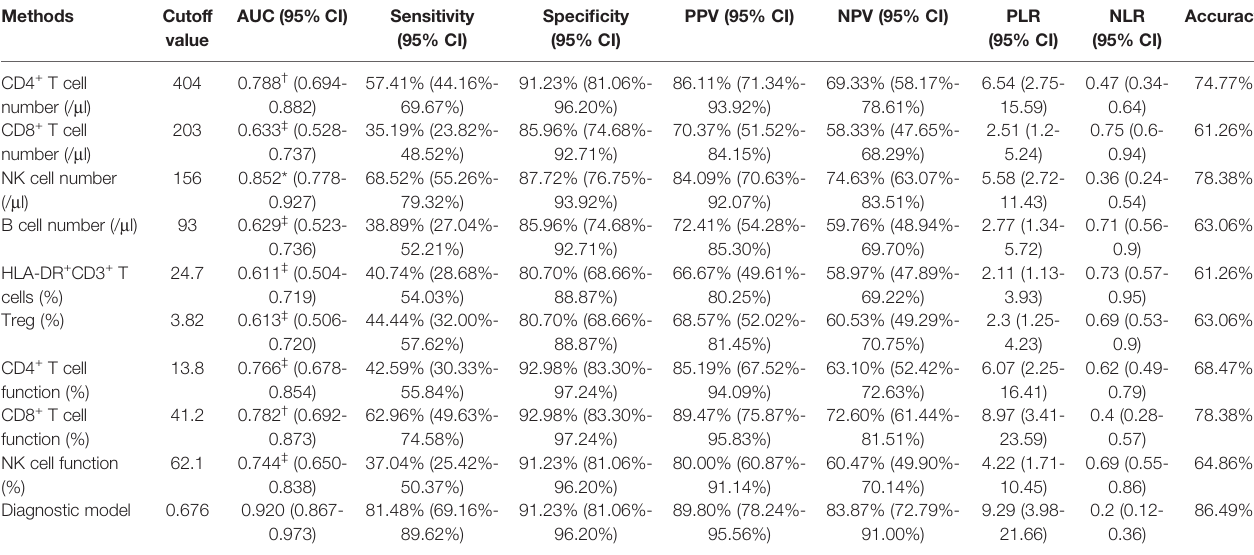
TABLE 2 | The performance of different methods for distinguishing between ATB and LTBI.